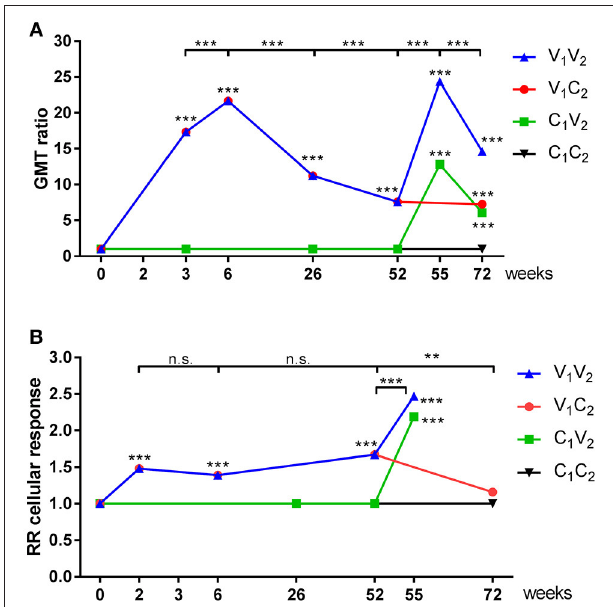
FIGURE 5 | GMT ratios of serological and relative response rates of cellular immune responses. GMT ratios (A) en Relative response rates (B) were calculated by mixed effects regression models for antibody titer (A) and IFN- γ spots (B) for vaccinated individuals and individuals of the control group during season 1 and season 2. Statistical analysis of a time point compared to baseline are depicted in the graph, while analysis between time points is depicted above the graphs. ** P < 0.01, *** P < 0.001, **** P < 0.0001.